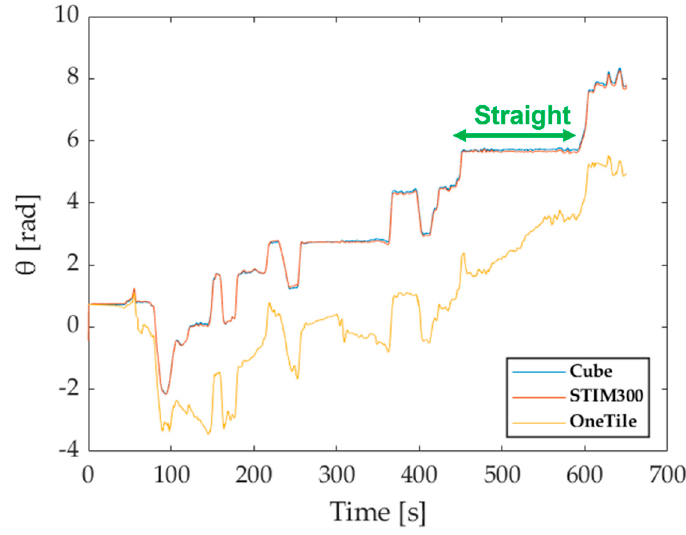
Figure 12. Heading angle comparison.